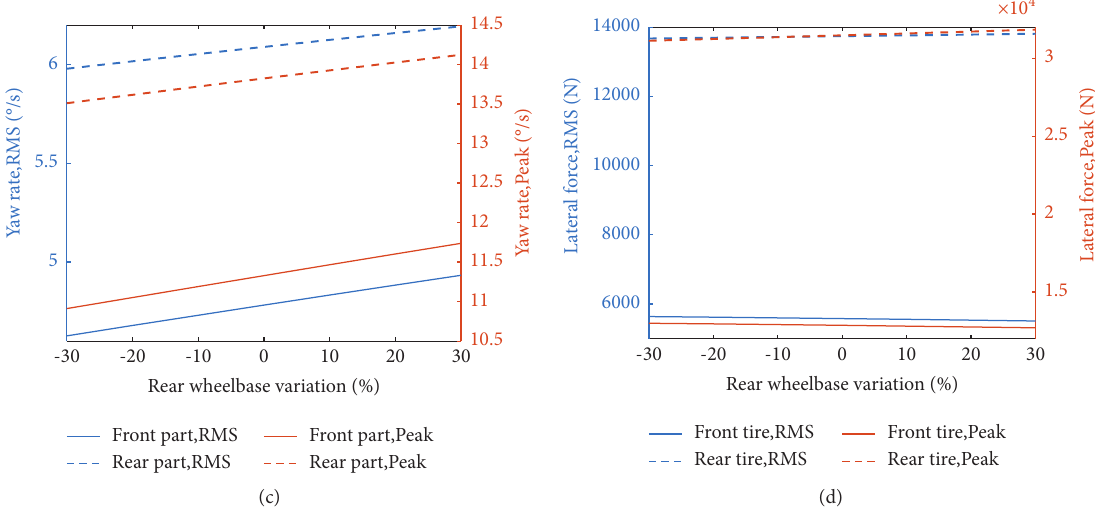
Figure 13: Vehicle performance of the rear wheelbase variation. (a) RMS and peak value of tire sideslip angle. (b) RMS and peak value of vehicle sideslip angle. (c) RMS and peak vehicle yaw rate. (d) RMS and peak value of lateral